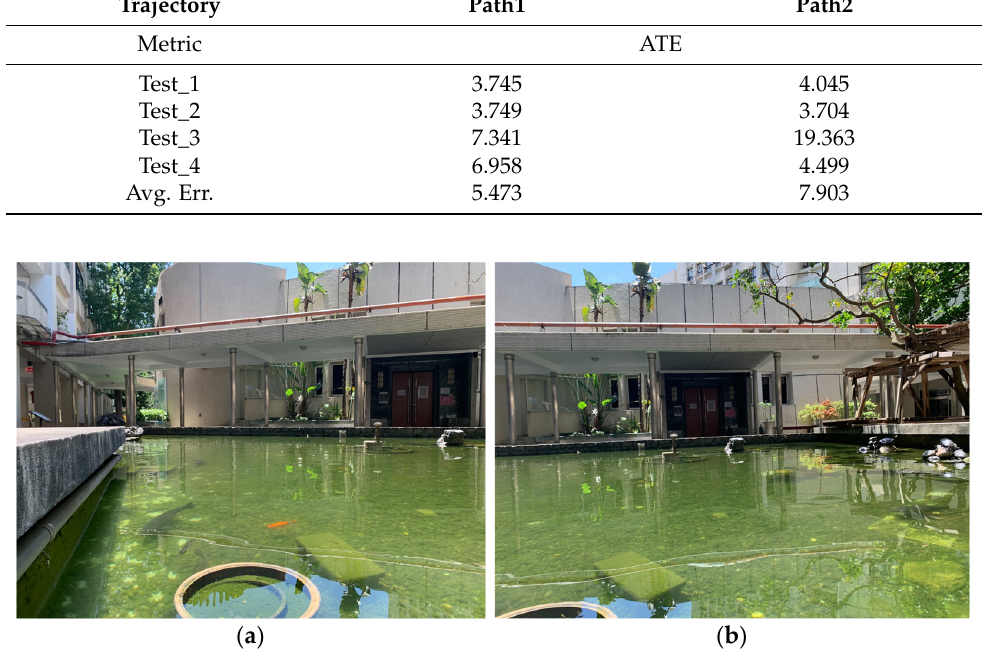
Figure 14. The original picture of feature-based image alignment. ( a ) Picture to the left after centering the camera. ( b ) Picture to the right after centering the camera.